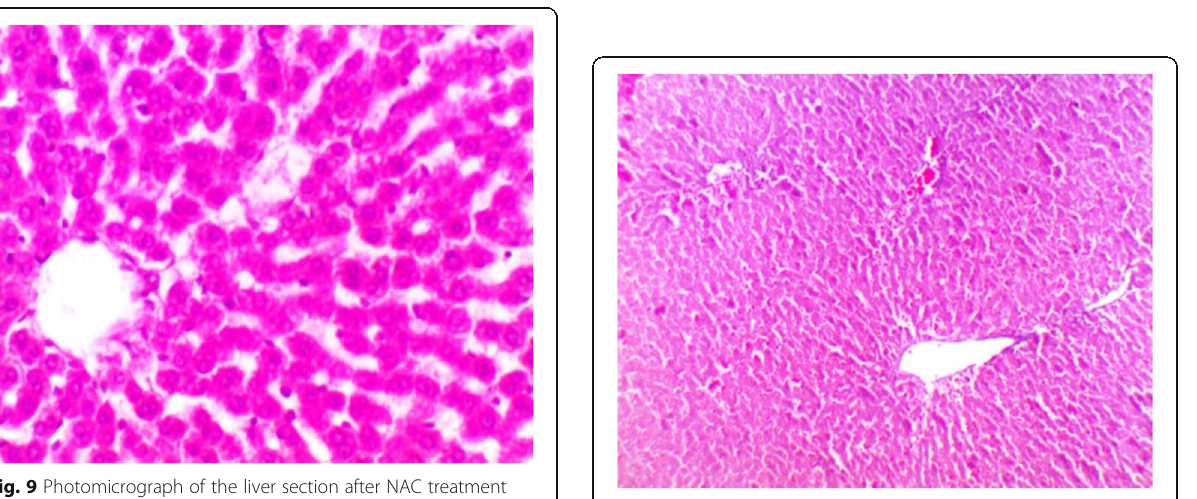
Fig. 11 Photomicrograph of treated liver sections treated (CCL4 + NAC) group showing less thickened fibrotic tissue (Masson ’ s trichrome